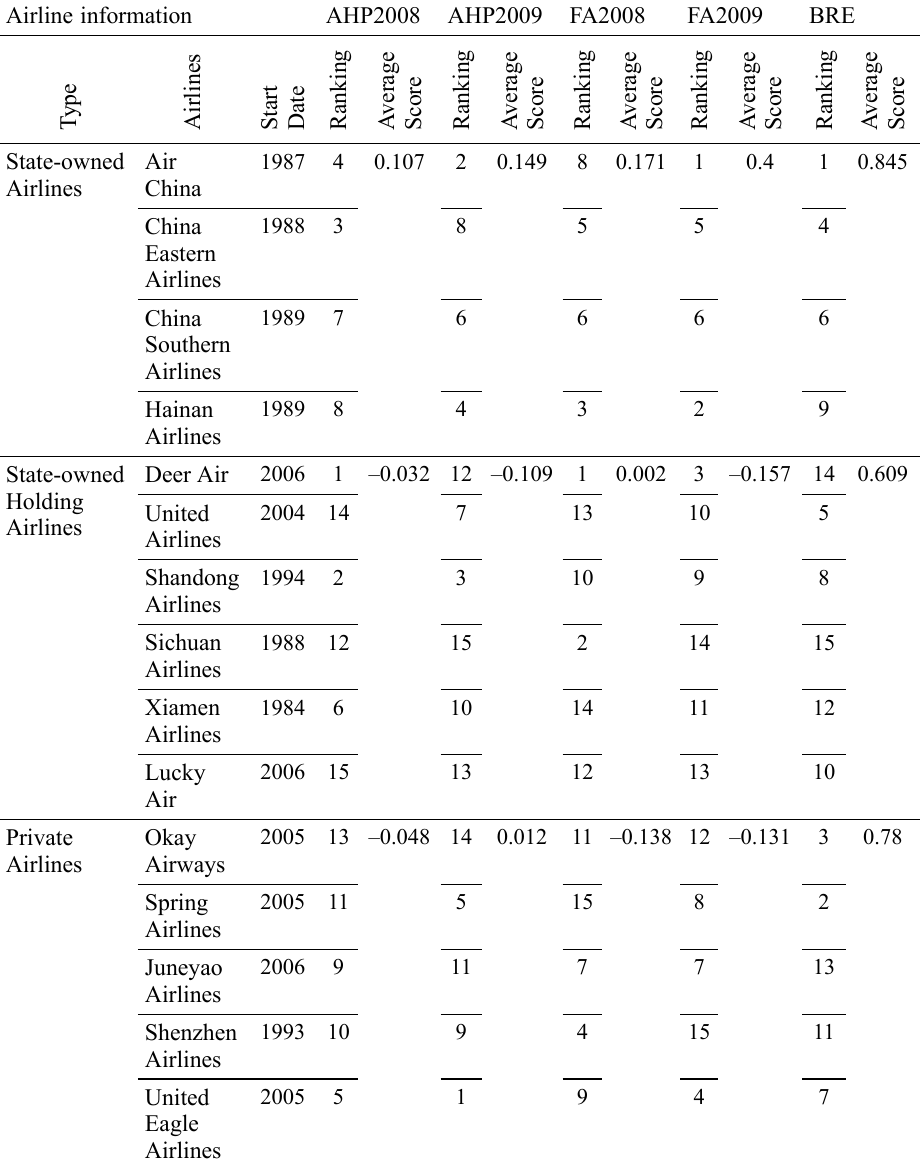
Table 19. Comprehensive competitiveness evaluation results of Chinese airlines Airline